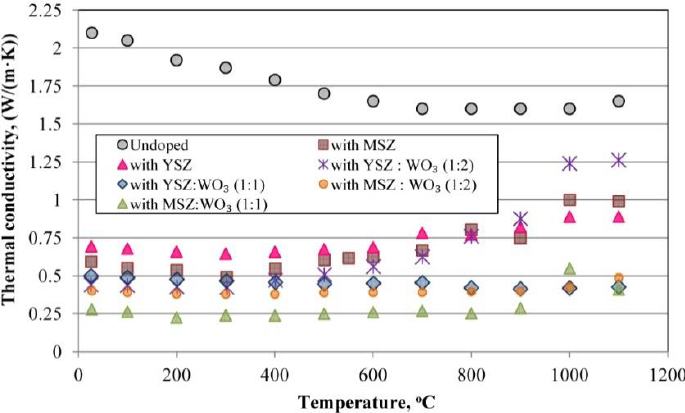
Figure 10. Thermal conductivity of the samples.